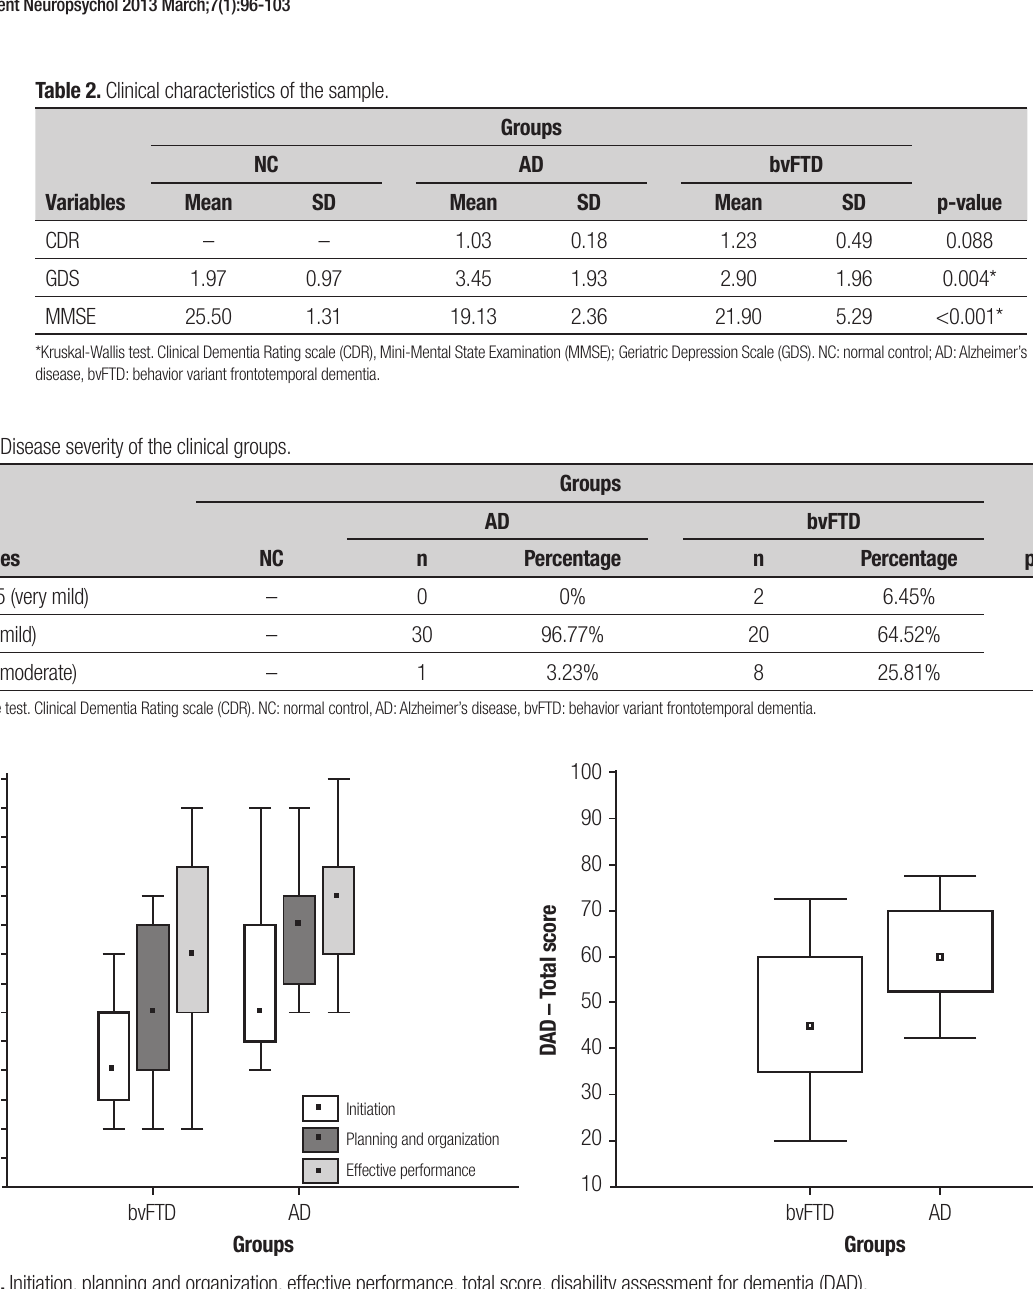
100 Functional profile of frontotemporal dementia Lima-Silva TB, et al.